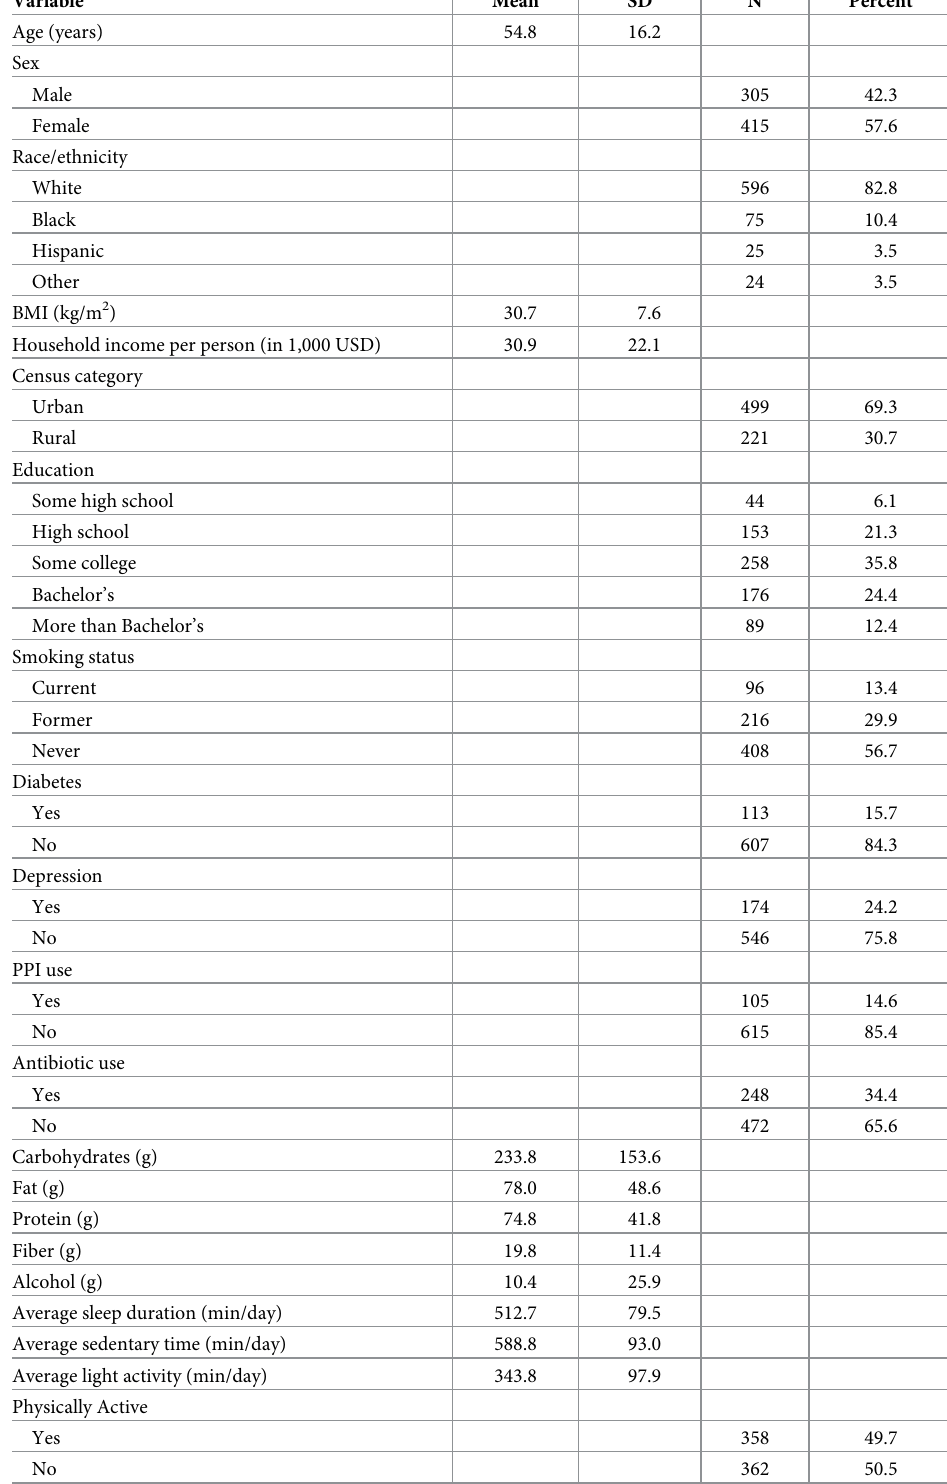
Table 1. Descriptive sample characteristics, Survey of the Health of Wisconsin,